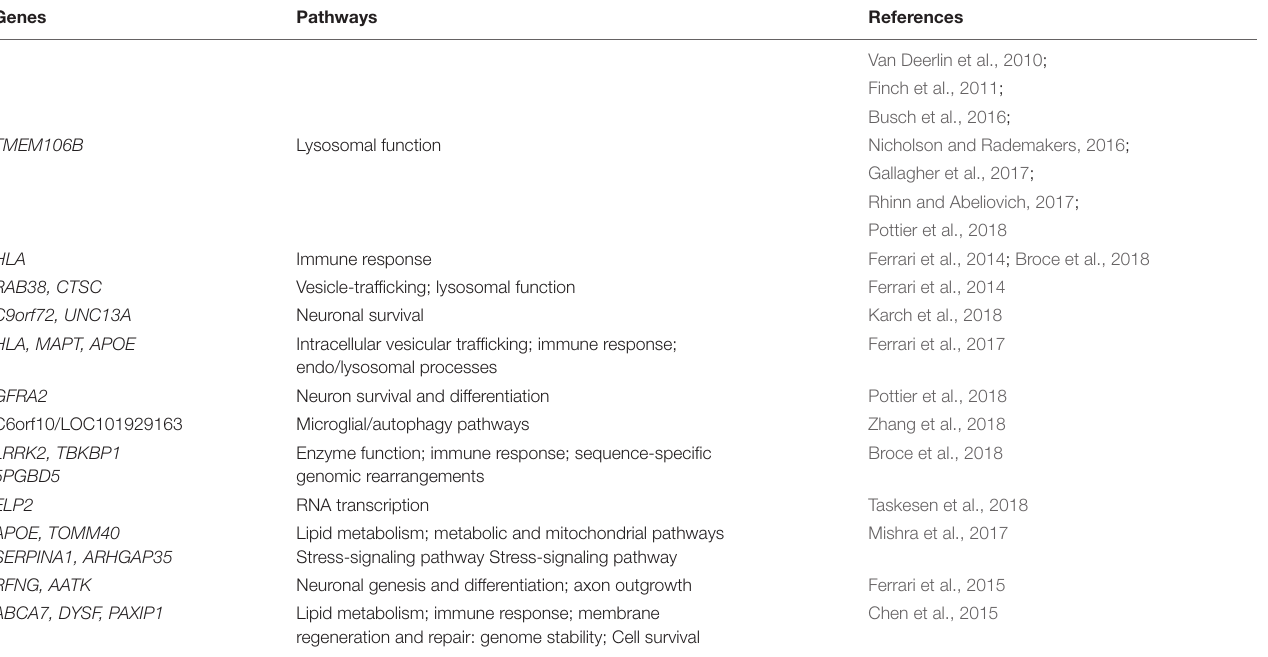
TABLE 1 | Genome-Wide Association Studies (GWAS) mediated identification of potential pathways contributing to FTD.